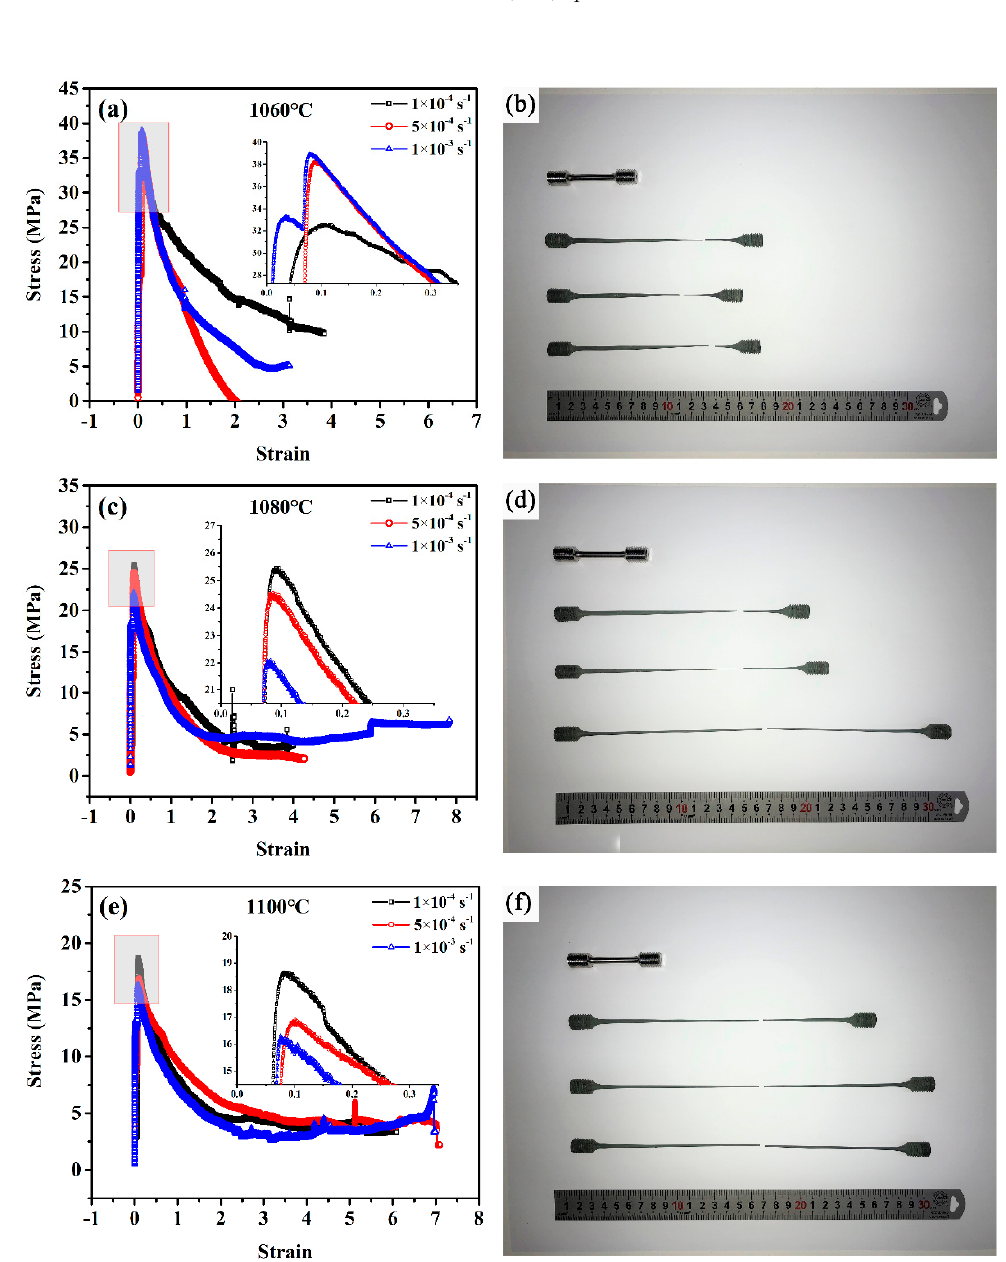
Figure 4. The stress–strain curve and tensile failure specimens at 1060 ◦ C ( a , b ), 1080 ◦ C ( c , d ) and 1100 ◦ C ( e , f ) with the initial strain rate of 10 − 4 s − 1 , 5 × 10 − 4 s − 1 and 10 − 3 s − 1 , respectively.